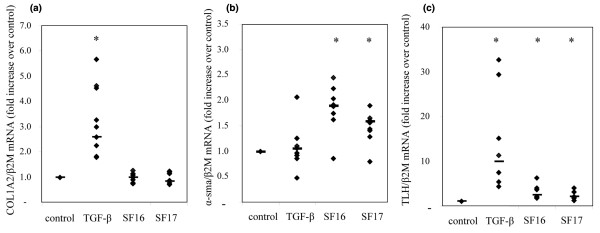
Expression of collagen type I, α-smooth muscle actin (α-sma) and telopeptide lysylhydroxylase (TLH) in healthy fibroblast like synoviocytes (FLSs) upon stimulation with transforming growth factor (TGF)-β and synovial fluid (SF). (a) Expression of collagen type I alpha 2 chain (COLIA2)/β2-microglobulin (β2M) mRNA, (b) α-sma/β2M mRNA and (c) TLH/β2M mRNA were measured after stimulation of healthy FLSs with 1 ng/ml TGF-β or 1/10 diluted SF from rheumatoid arthritis patients. TGF-β increased COLIA2 expression, but had no effect on α-sma expression. Stimulation of healthy FLSs with synovial fluid from RA patients (RASF) did not lead to an increase in COLIA2/β2M but did induce α-sma/β2M mRNA expression. TLH expression was induced by both TGF-β and SF. Horizontal lines indicate the median; diamonds indicate FLSs from individual subjects. * indicates P < 0.05.